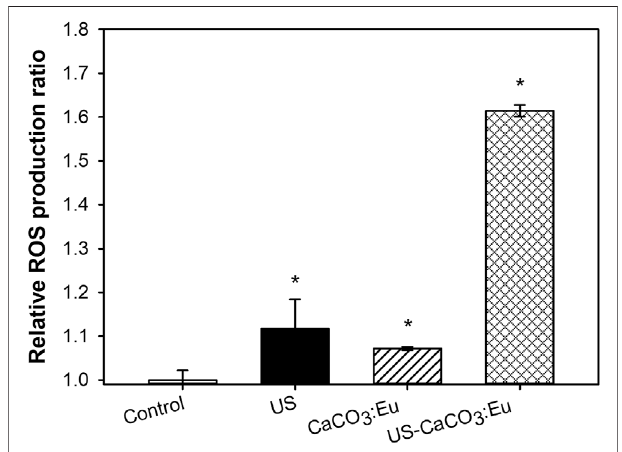
FIGURE 8 | ROS production of 3T3-L1 cells treated with CaCO 3 : Eu under ultrasound irradiation, * p < 0.05.